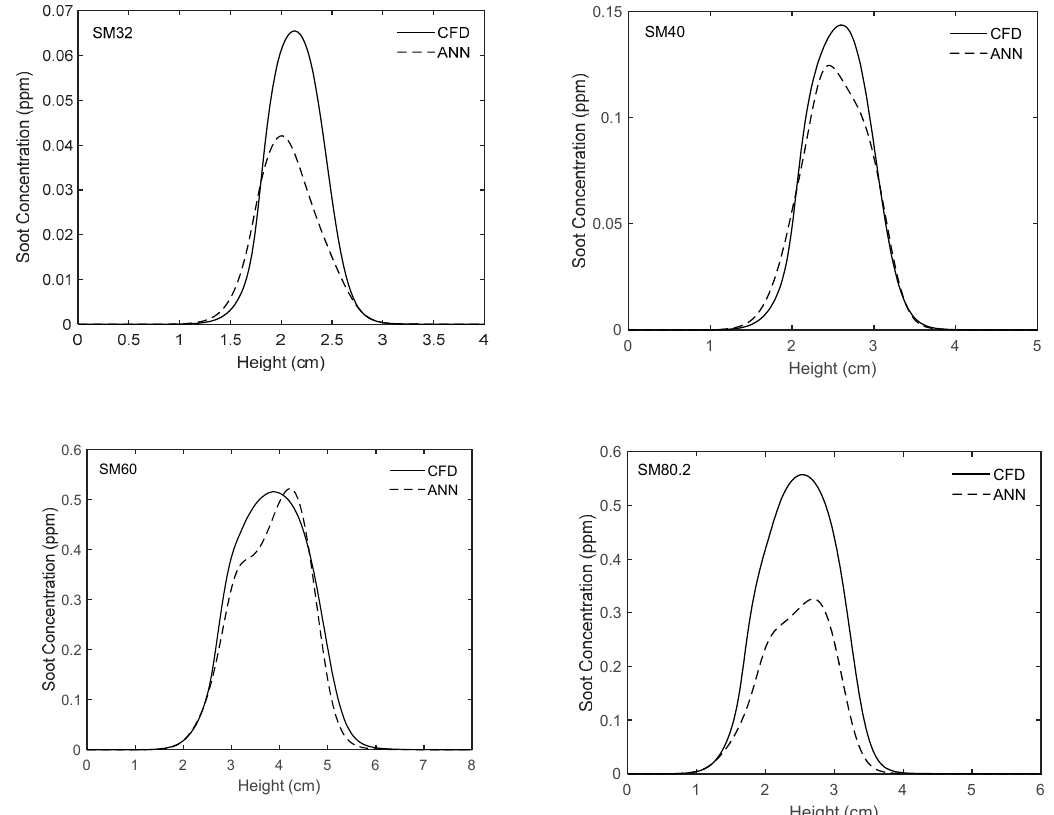
Figure 10. Comparison of experimentally-validated CFD results and those obtained from the ANN for different flames along the centerline.